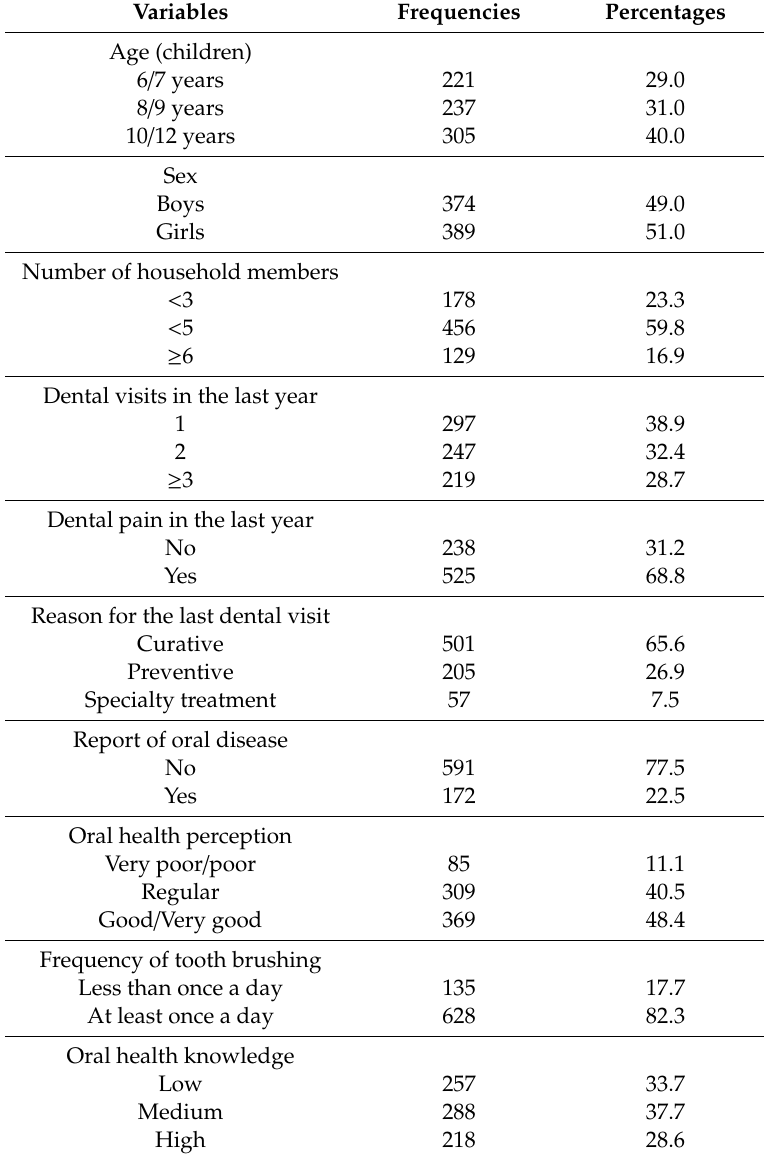
Table 1. Description of the sociodemographic and health variables in the study sample. Variables